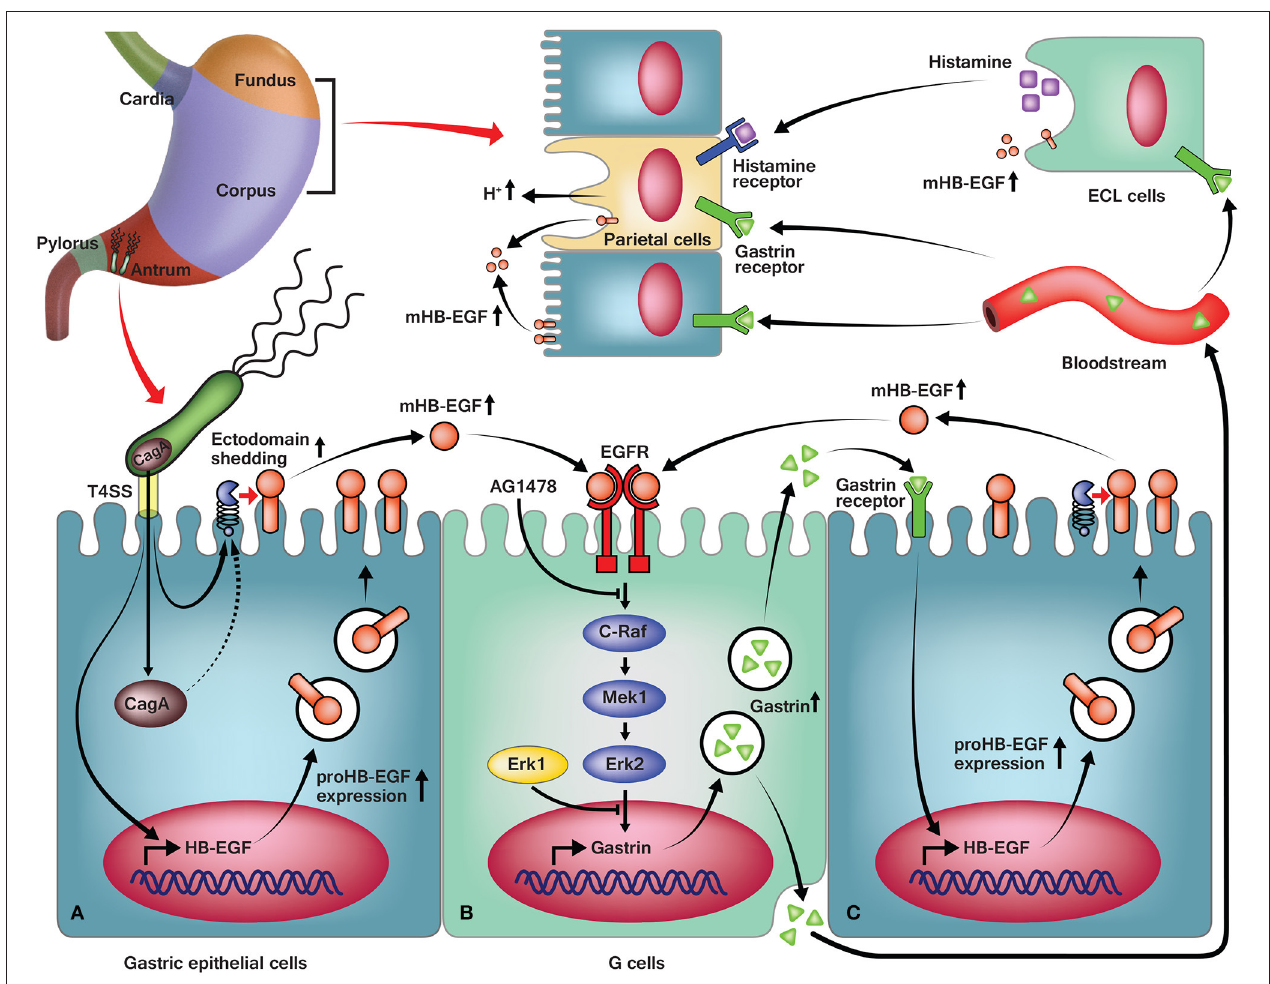
FIGURE 7 | A predictive model of H. pylori -induced gastrin expression. (A) In antral gastric epithelial cells, H. pylori induces expression of HB-EGF via the T4SS, and downstream shedding of HB-EGF via the T4SS and partially, CagA. (B) Increased mature HB-EGF binds to the EGF receptor in the G cells and activates C-Raf, Mek1, and Erk2 in the Erk pathway, resulting in an increase of gastrin expression. (C) The secreted gastrin is transported to its site of action in paracrine and endocrine manners, and upregulates HB-EGF expression in the antrum, corpus, and fundus. (Top) Also, the gastrin stimulates ECL cells to produce more histamine, which co-stimulates parietal cells with gastrin, to induce gastric acid